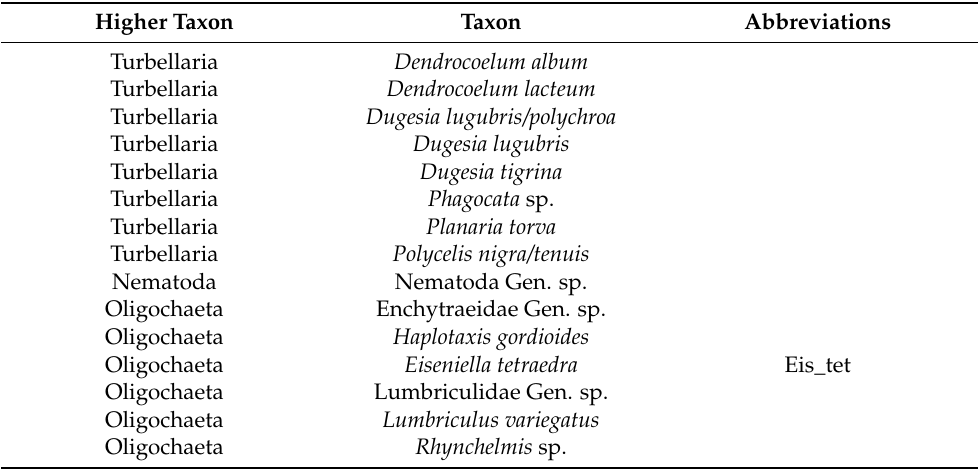
Table A1. Benthic invertebrate taxa recorded at near-natural sites of large